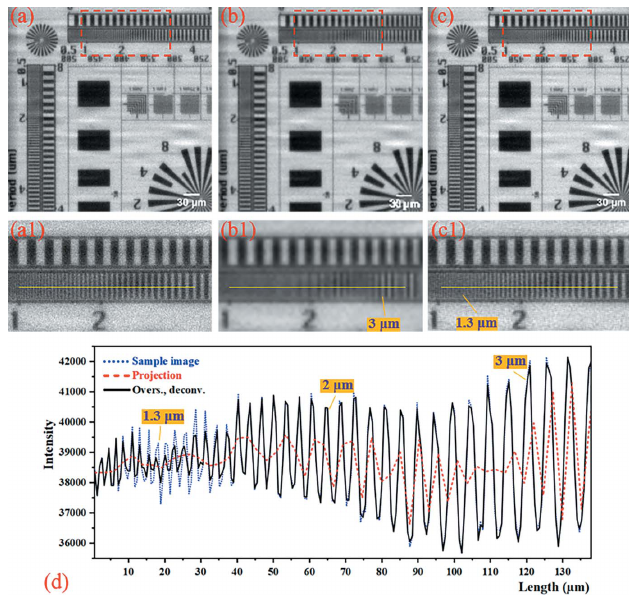
Figure 5 Results of the 4 (cid:2) 4 mode numerical simulation experiment. ( a ) The sample image (pixel size: 0.65 m m (cid:2) 0.65 m m; pixel number: 588 (cid:2) 588). ( b ) The projection (pixel size: 2.6 m m (cid:2) 2.6 m m; pixel number: 147 (cid:2) 147). ( c ) The oversampled image with deconvolution (pixel size: 0.65 m m (cid:2) 0.65 m m; pixel number: 588 (cid:2) 588). Panels ( a )–( c ) are only part of the image to show the details more clearly. Panels ( a 1)–( c 1) correspond to the magnified images in the red boxes of ( a )–(c), respectively. ( d ) The intensity profiles at the yellow line of ( a 1)–( c 1).